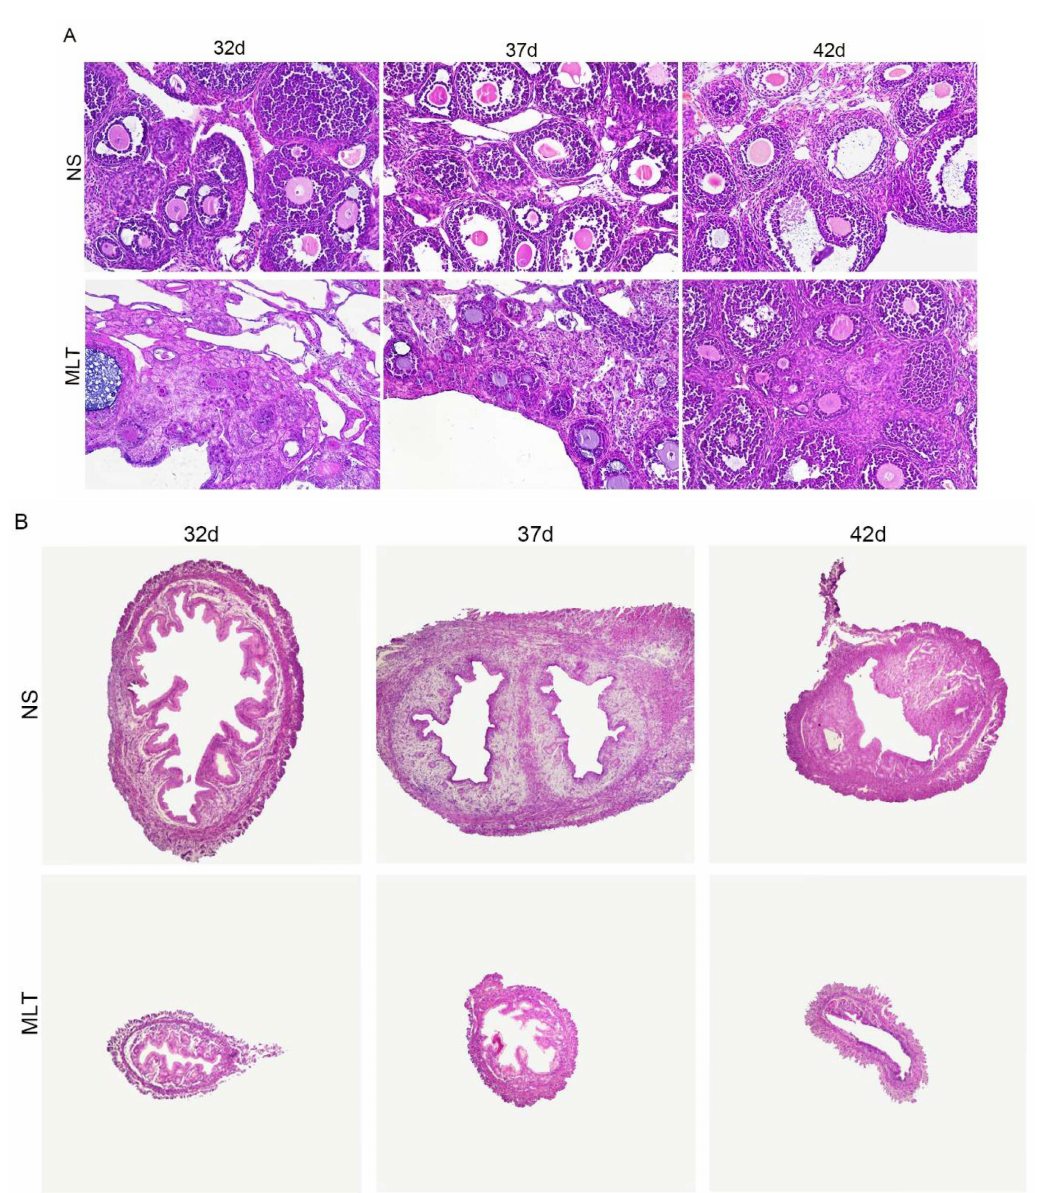
Figure 3. Melatonin’s effects on female mice’s follicular maturation and uterine wall thickness (n = 13). ( A ) Development of follicles in each group by HE staining, magnification, 200 × . ( B ) Development of uterus in each group by HE staining, magnification, 40 × . 32 d, 32 days; 37 d, 37 days; 42 d, 42 days; NS, normal saline; MLT,